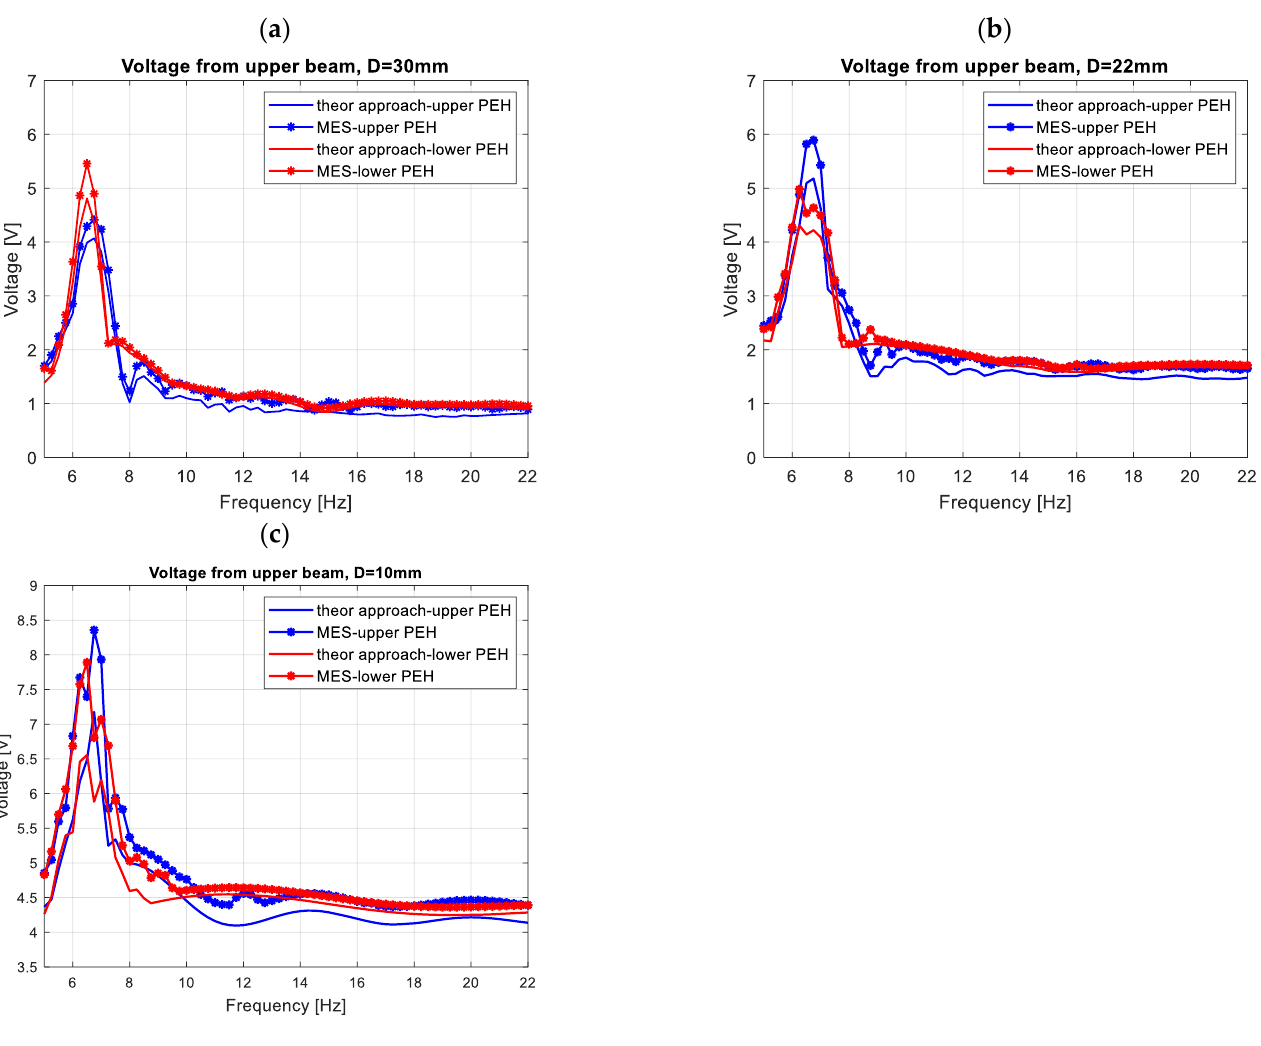
Figure 8. The comparison of theoretical and numerical results of the voltage output generated from piezo-stripe harvesters by different beam spaces ( a ) D = 30 mm, ( b ) D = 22 mm, ( c ) D = 10 mm.